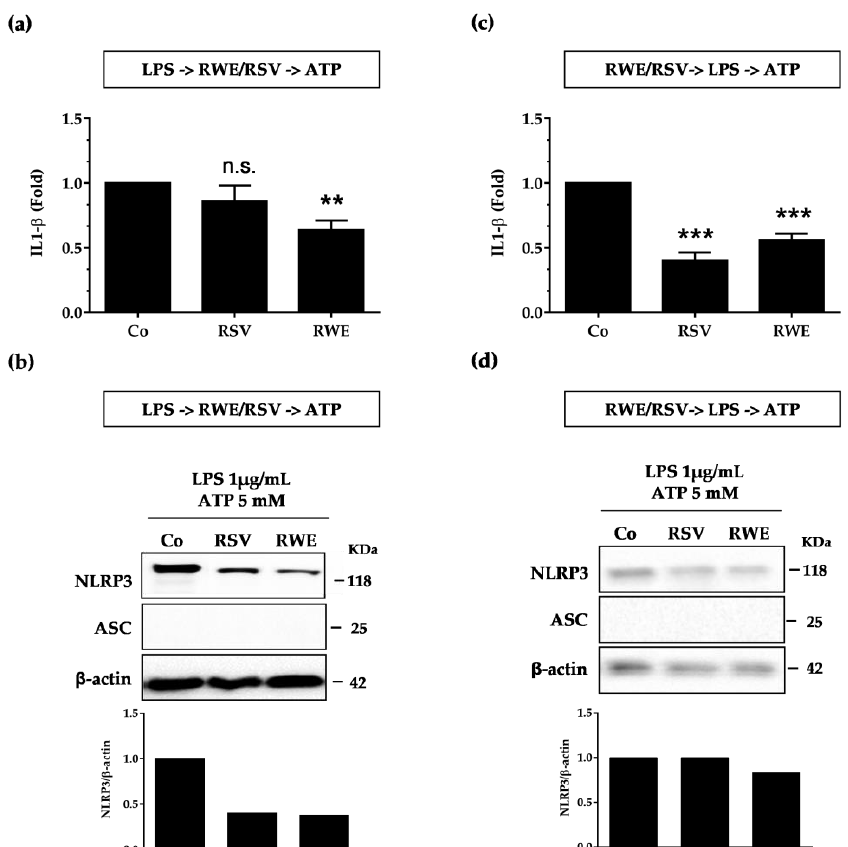
Figure 5. RWE prevents both priming and activation from ATP in macrophages. ( a ) LPS -> RWE/RSV -> ATP sequence: Raw 264.7 cells were exposed to 1 µ g/mL of LPS for 5.5 h, then treated or not with RWE (100 µ g/mL) or RSV (60 µ M) for 30 min and finally exposed for an additional 30 min to 5 mM ATP. Secreted IL-1 β in cell supernatants was analyzed by ELISA at the end of the treatments. Data are expressed as fold changes in secreted IL-1 β levels as compared to cells treated only with LPS + ATP (Co) and are mean ± s.d. of three independent experiments. p -values were determined by the multiple Student t test. ** p < 0.01, *** p < 0.001, n.s.: not significant. ( b ) Western blot analysis of NLRP3 and ASC protein expression in Raw 264.7 macrophages after cell treatments as described in ( a ). Representative blots from three independent experiments are shown. β -actin was used as loading control. Histograms: quantifications by densitometry of representative blots. Plotted data are fold changes as compared to LPS+ATP-treated cells (Co). ( c ) RWE/RSV-> LPS -> ATP sequence: Raw 264.7 cells were pretreated or not with RWE (100 µ g/mL) or RSV (60 µ M) for 30 min, prior to NLRP3 inflammasome priming with 1 µ g/mL of LPS for 5.5 h and subsequent activation by 5 mM nigericin for 30 min. Secreted IL-1 β in cell supernatants was analyzed by ELISA at the end of the treatments. Data are expressed as fold changes in secreted IL-1 β levels as compared to cells treated only with LPS + ATP (Co) and are mean ± s.d. of three independent experiments. p -values were determined by the multiple Student t test. ** p < 0.01, *** p < 0.001. ( d ) Western blot analysis of NLRP3 and ASC protein expression in Raw 264.7 macrophages after cell treatments as described in ( c ). Representative blots from three independent experiments are shown. β -actin was used as loading control. Histograms: densitometry quantifications of representative blots. Plotted data are fold changes as compared to LPS+ATP-treated cells